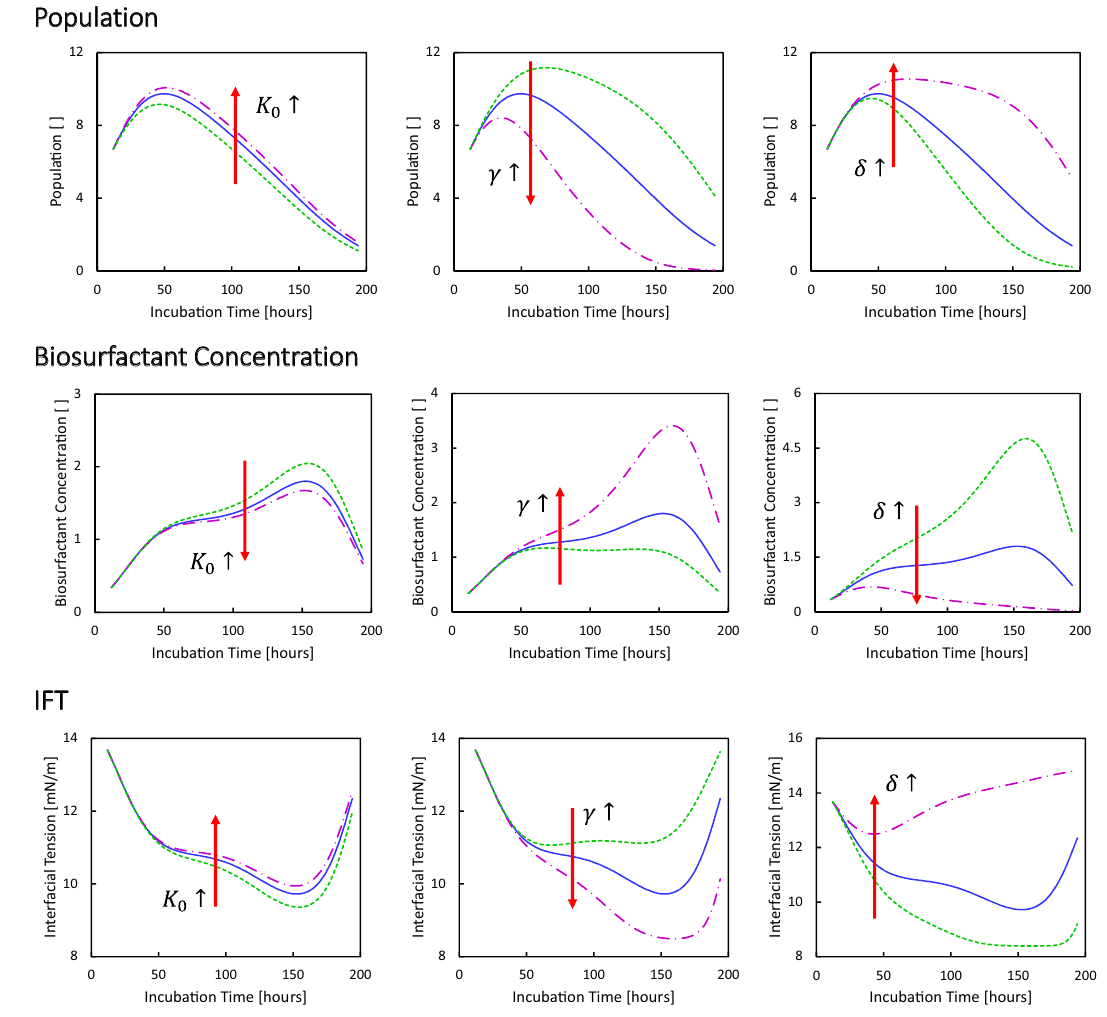
Fig. 9 Parameter sensitivity in coupled-simultaneous model. The sensitivity study uses Eq. (14) and the parameters include: carrying capacity K 0 , toxicity constant 𝛾 (1/h), and predation factor 𝛿 (1/h). The continuous-blue line deploys the value in Fig. 8, the halved value